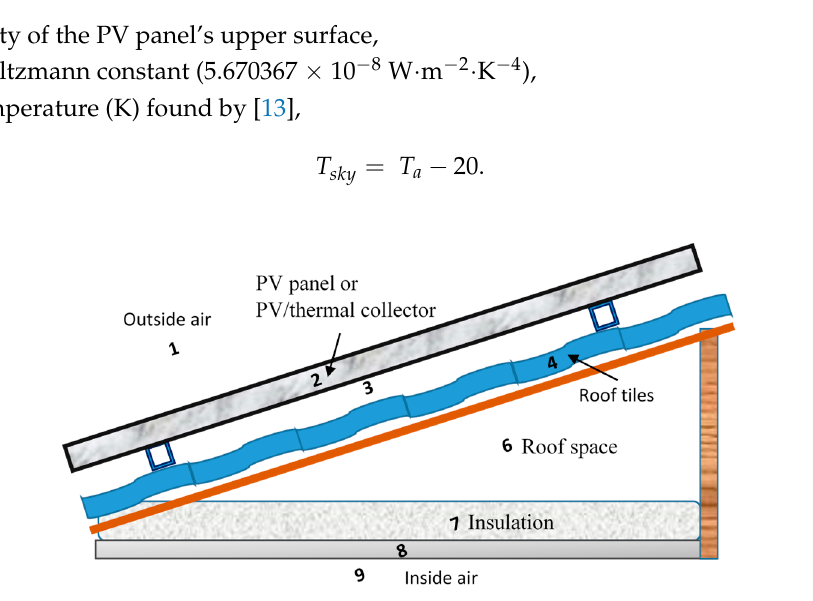
Figure 1. Gabled roof covered with a photovoltaic (PV) panel.